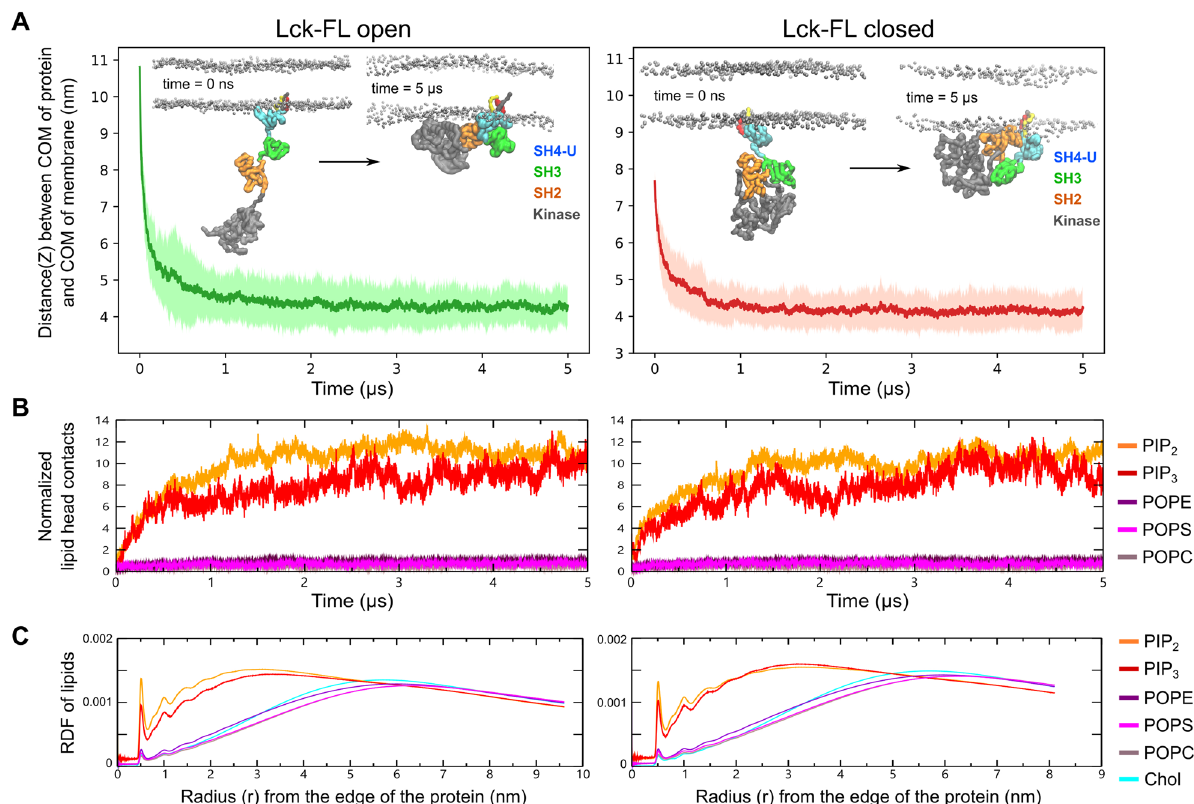
Figure 2. Membrane association and lipid interactions of the open and closed Lck-FL conformations. ( A ) Association of open and closed conformations of Lck-FL with the membrane is indicated by the reduction in distance between the center of mass (COM) of Lck-FL and COM of the membrane versus time. The dark green/ red lines indicate the average distance from all 20 CGMD simulations while the light green/red region indicate standard deviation. See Fig. S2C for distance vs time plots from individual simulations. ( B ) Normalized number of contacts between Lck and lipid headgroups versus time averaged from all 20 CGMD simulations. The number of headgroup interactions of each phospholipid type is normalized by the number of lipids of the respective lipid type in the membrane. See Fig. S1B for non-normalized contacts of lipid headgroups with Lck. ( C ) The radial distribution function (RDF) of all lipid types around Lck calculated throughout the simulation time from all 20 CGMD simulations. The RDF is normalized by the total number of lipids in the membrane of that system to enable comparison between the open and closed conformations of Lck-FL. Note: The Lck-FL open and closed systems contain different number of lipids in the membrane due to different sizes of the bilayers used in our